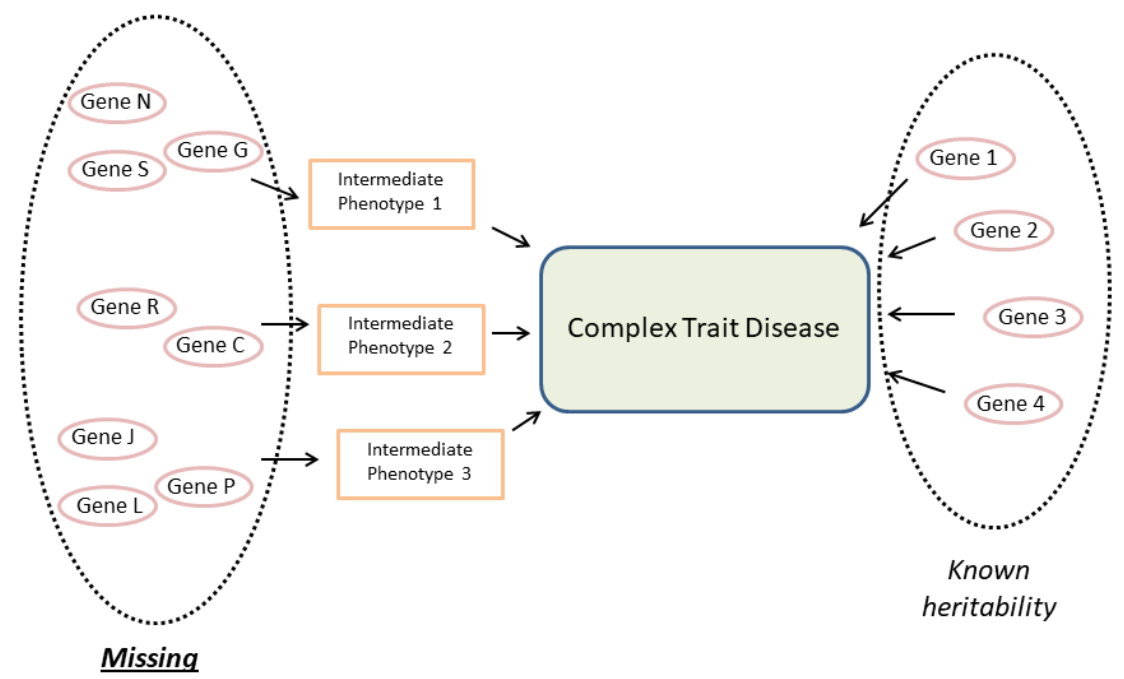
Figure 2. Complex traits have a polygenic component associated with the phenotypic variation that can be directly detected as known heritability. Many intermediate phenotypes are also involved in the pathogenesis of a complex trait. These intermediate phenotypes have their heritability, formed by genetic determinants that contribute to their phenotypic variation among individuals (in the figure, genetic determinants are quantitative trait loci (QTLs)). Most genetic components associated with the phenotypic variability of complex traits cannot be detected, and so comprise the missing heritability. We proposed that missing heritability could be explained by the genetic determinants associated with the heritability of intermediate phenotypes and that these elements do not have a large enough effect of being capable of detection at the level of the complex